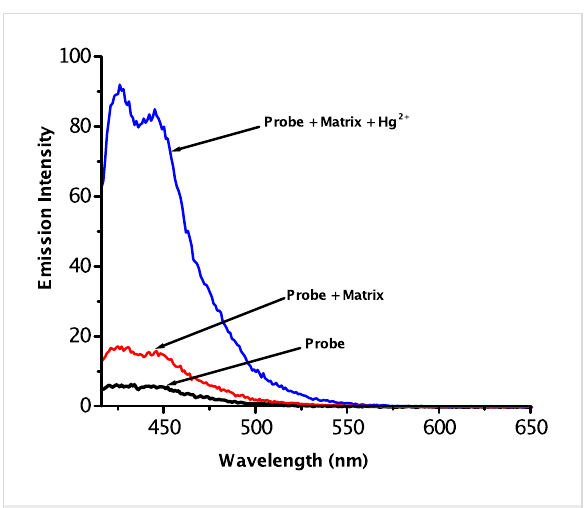
Figure 5: Emission spectra of acrithion 2 (2.5 ×10 − 6 M), acrithion 2 + matrix consisting of 2.5 × 10 − 4 M each of Li + , Na + , K + , Mg 2+ , Ca 2+ , Ba 2+ , Co 2+ , Ni 2+ , Cu 2+ , Zn 2+ , Cd 2+ , Ag + and Pb 2+ and acrithion 2 + matrix + Hg +2 (5.1 × 10 − 5 M).